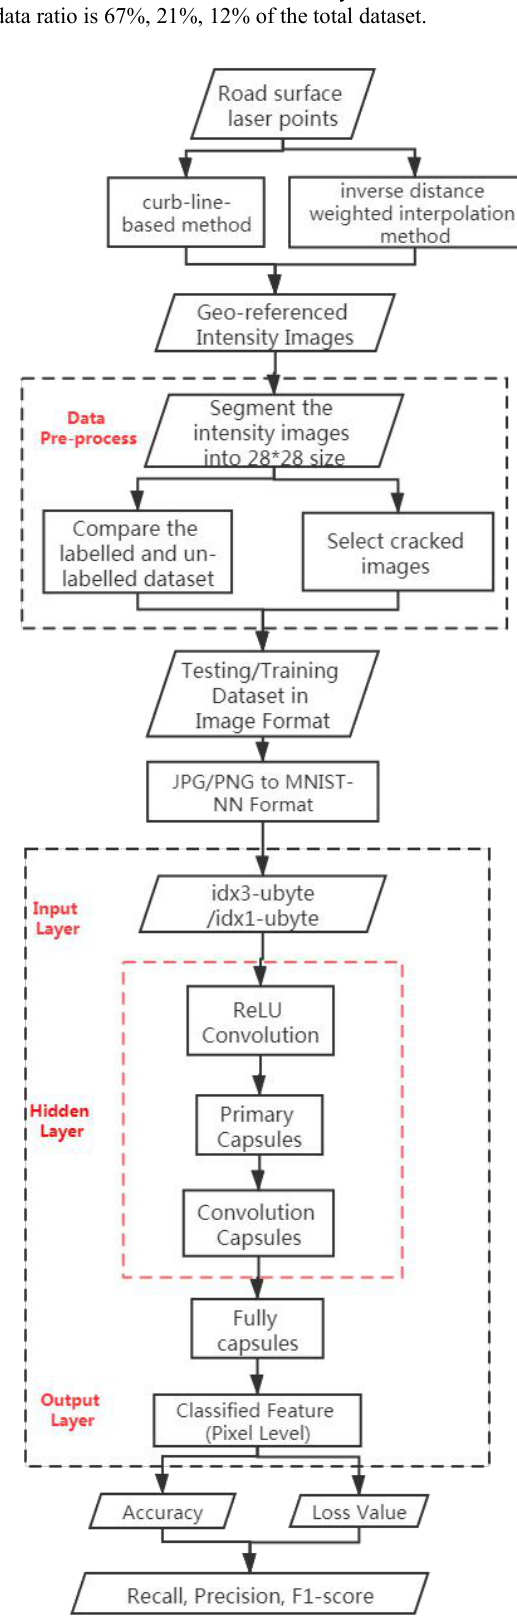
Figure 4. Flowchart of the proposed